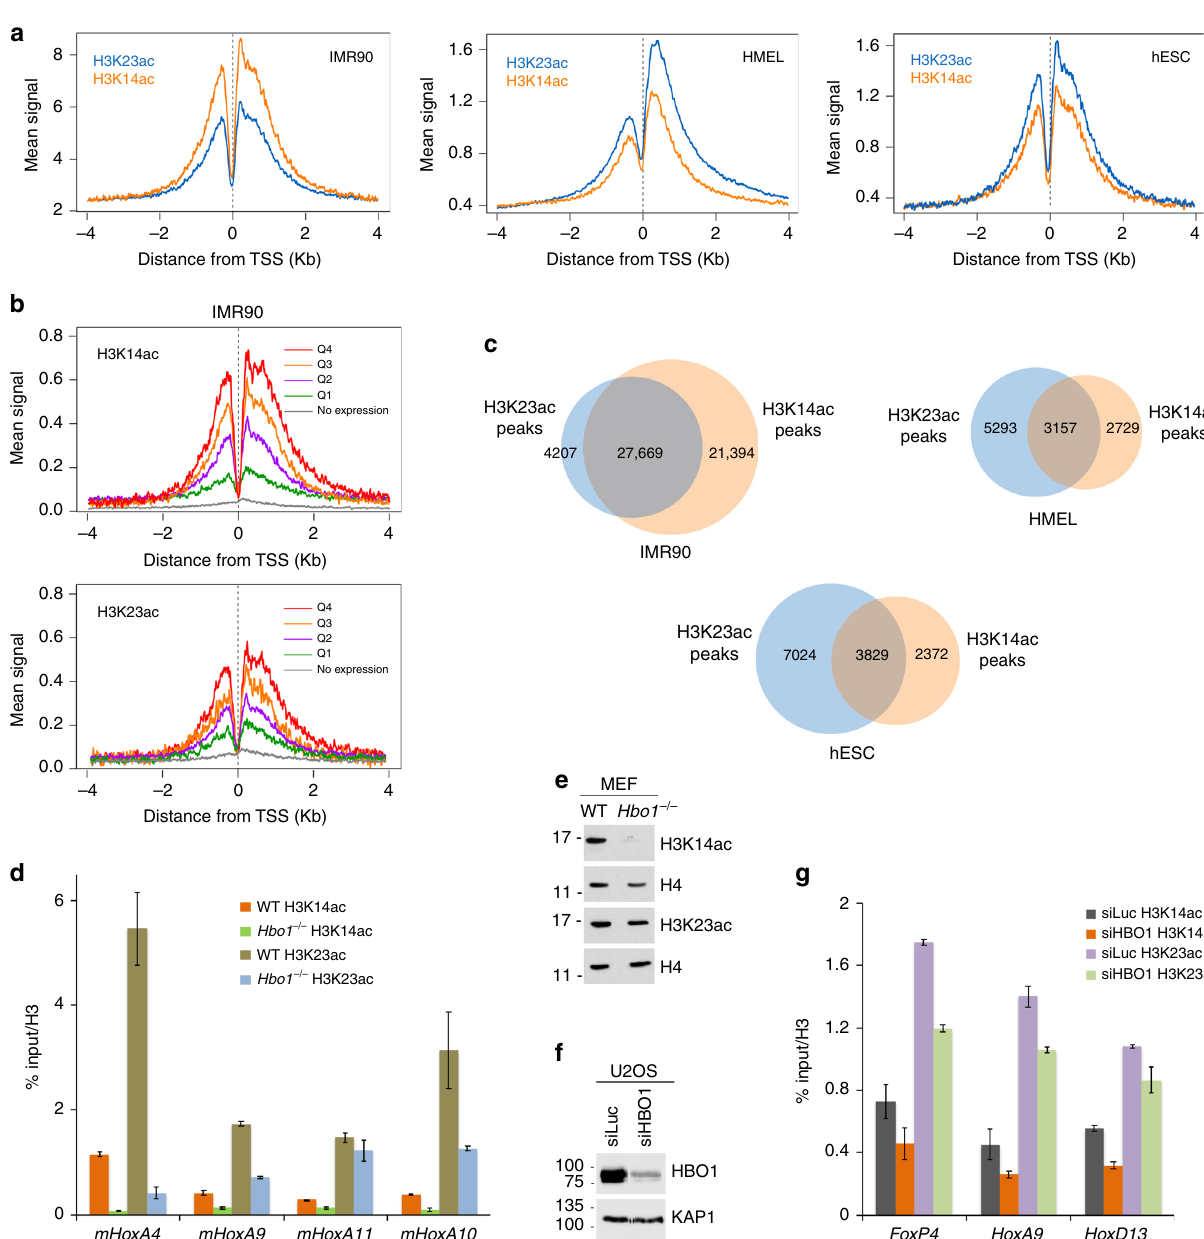
used at a 1:10,000 dilution and the immunoblots were visualized using a Western Lightning plus-ECL reagent (Perkin-Elmer). Anti-HA-HRP (clone 3F10, Roche) was used at a 1:2000 dilution. Source data are provided as a Source Data fi le. HAT activity assays with puri fi ed MORF complexes . Acetyltransferase activity of the puri fi ed complexes was measured with 0.125µCi of 3 H labeled Ac-CoA (2.1Ci/ mmol; PerkinElmer Life Sciences). The amount of the different puri fi ed MORF NATURE COMMUNICATIONS| (2019) 10:4724